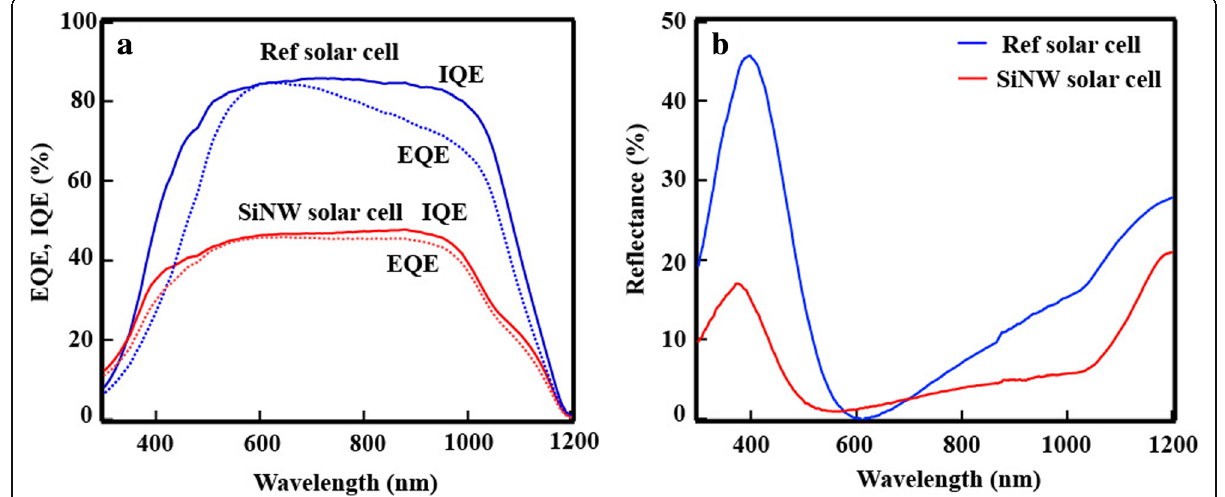
Fig. 8 a EQE and IQE of a SiNW solar cell and a reference solar cell. b Reflectance of a SiNW solar cell and a reference solar